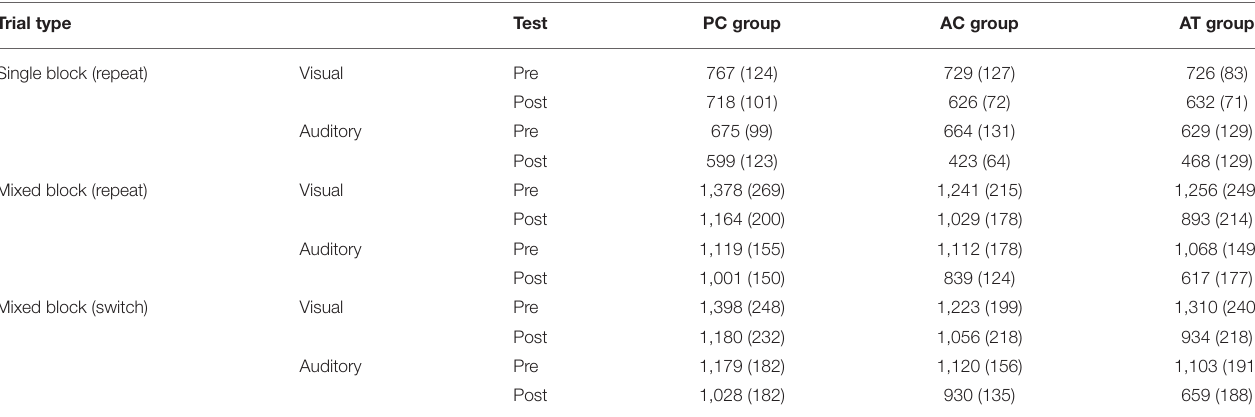
TABLE 2 | Mean RTs (ms) in the task switching assessments at pre- and post-test, for the average of the two single task blocks with repeat trials, the average of repeat trials in the mixed block, and the average of the switch trials in the mixed block in young adults (Data are based on the study of Kattner et al., 2019). Trial